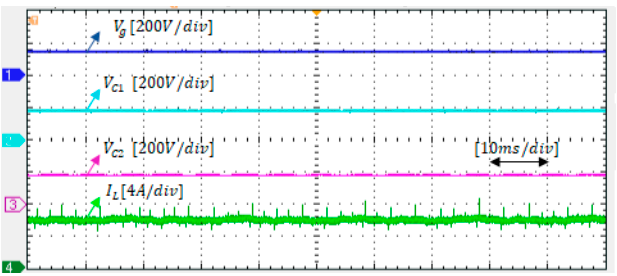
Figure 11. Experimental results of the DC input voltage ( V g ), capacitor voltages ( V C 1 and V C 2 ), and inductor current ( I L ) of the proposed method.